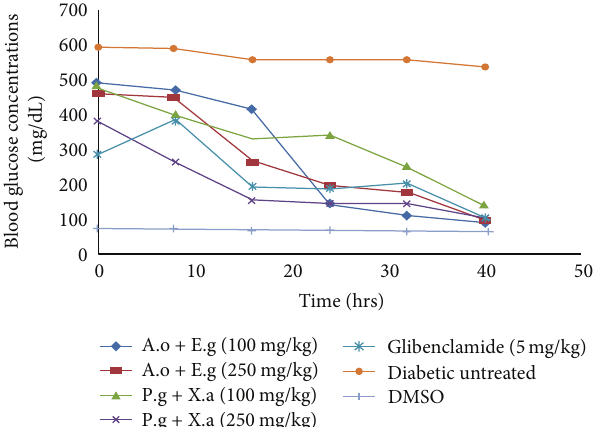
Figure 13: The effect of combined plants extracts on blood glucose concentrations at different time intervals. A.o + E.g = Anacardium occidentale + Eucalyptus globulus , P.g + X.a = Psidium guajava + Xylopia